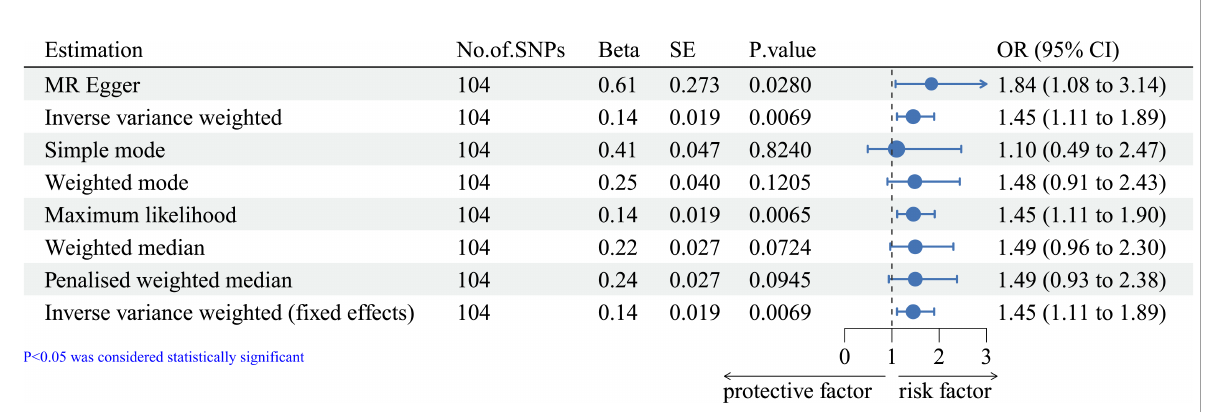
FIGURE 1 Forest plot of MR methods of the effect of telomere length on the prognosis of total breast cancer. MR, Mendelian